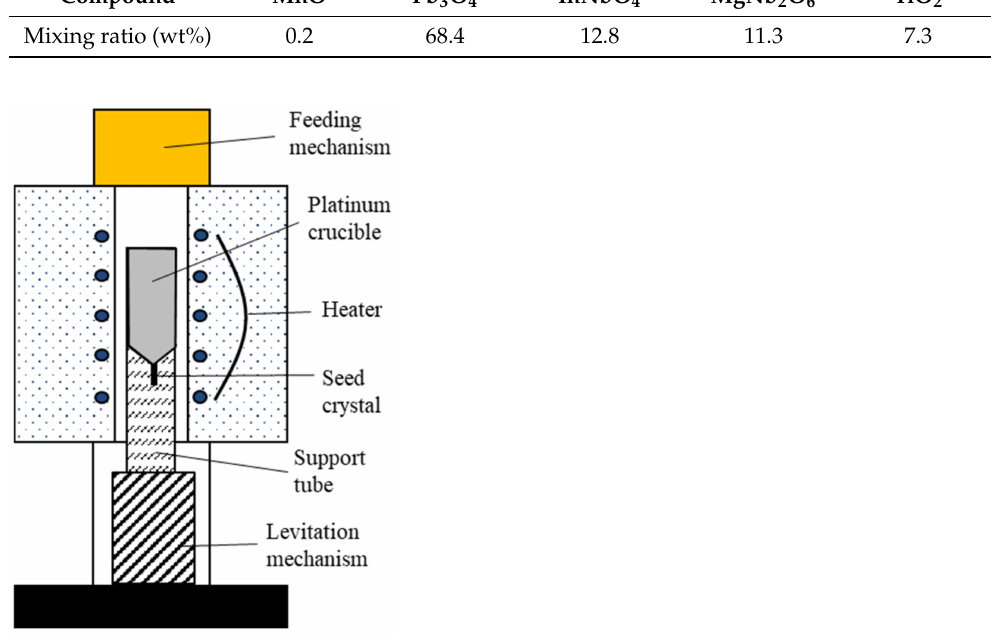
Figure 1. Schematic configuration of growth system for continuous-feeding Bridgman